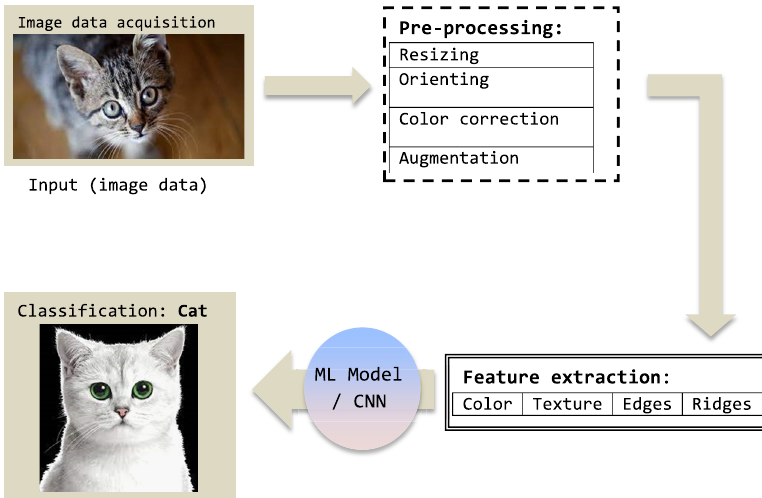
Figure 5: Illustration of the process fl ow of acquiring, processing, analyzing, and understanding in computer